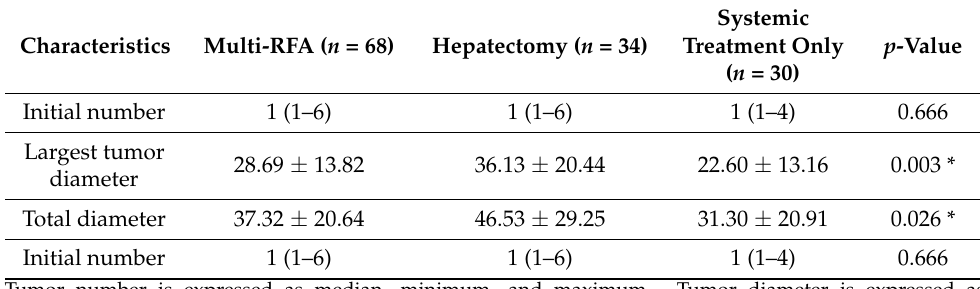
Table 2. Characteristics of initial liver tumor